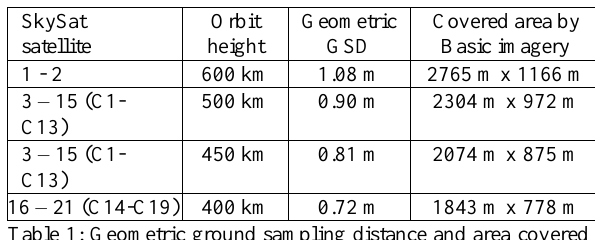
Figure 6: Relation incidence angle  and nadir angle